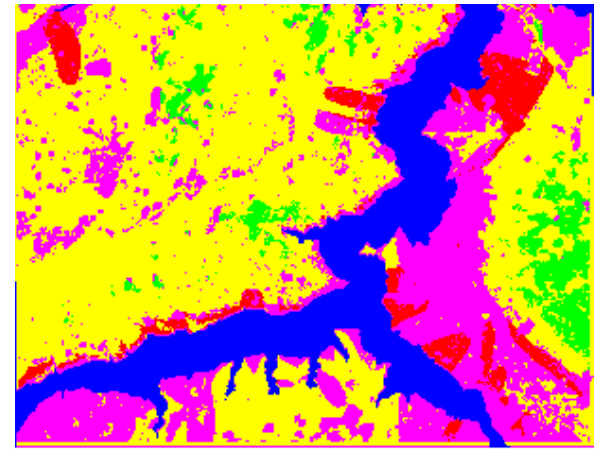
Figure 21. Forecast result of Maximum likelihood.